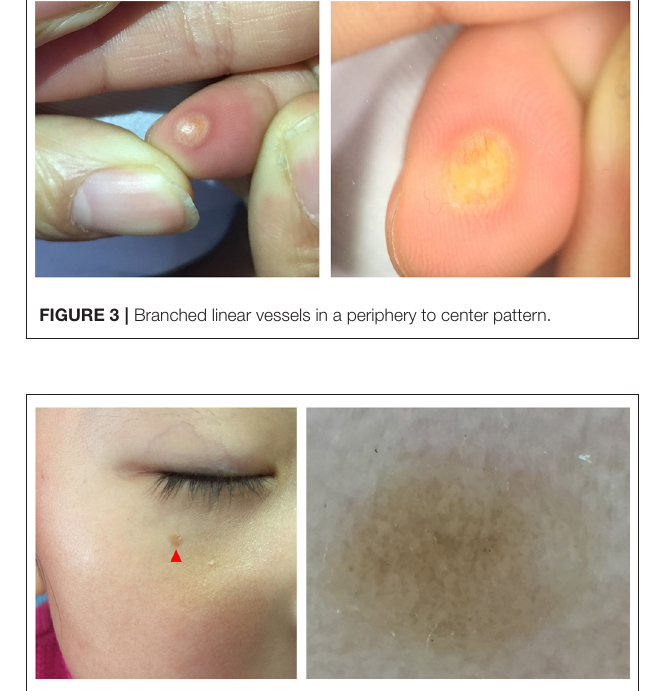
FIGURE 4 | Central pigment network (Left) and its clinical appearance (Right) , arrow head.